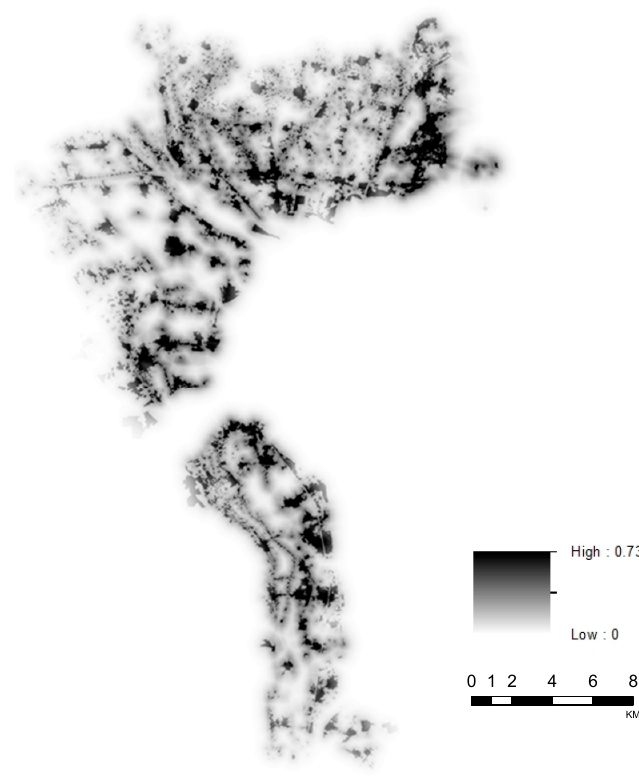
Figure 4. Probability map of urban expansion in the PUAs.